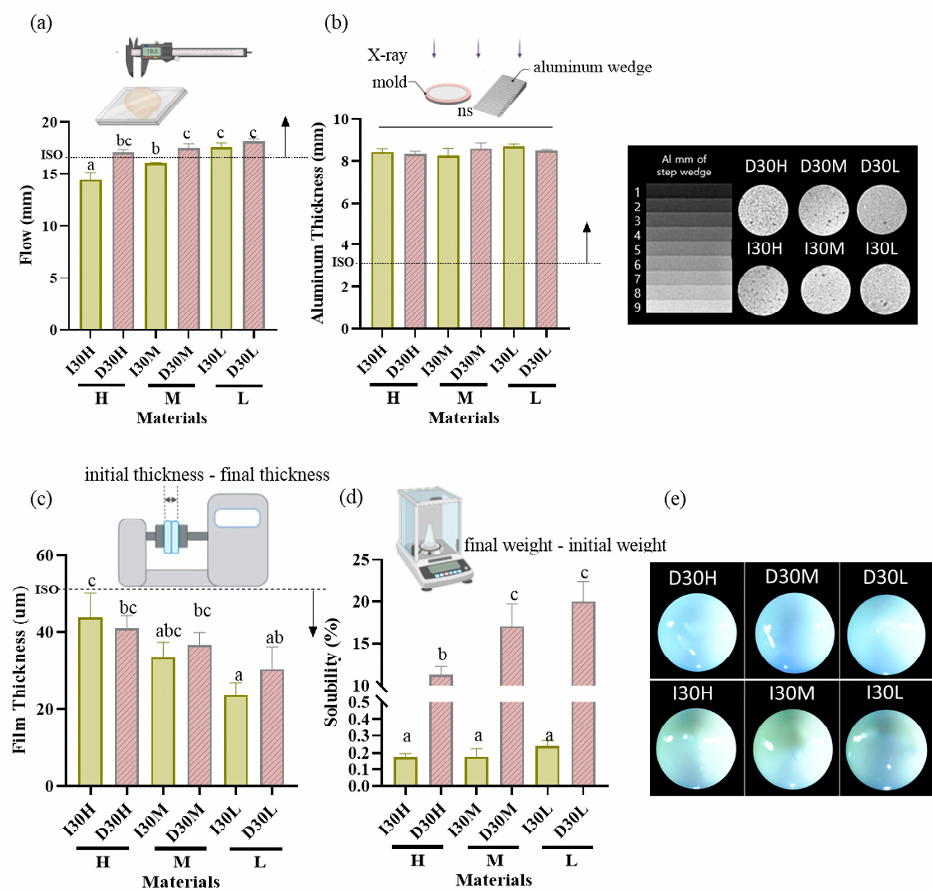
Figure 1. Physical properties of iodoform-based and NaI-based pastes (I30 and D30). ( a ) Flowability. All values except I30H and I30M were above 17 mm (ISO standard). ( b ) Radiopacity. All the aluminum thickness values were above the 3 mm Al (ISO standard). ( c ) Film Thickness. All groups met the ISO standard, which is under 50 µm. ( d ) Solubility. The solubility of D30 was higher than I30. ( e ) Optical microscopy images depicting the D30 and I30 groups, distinguished by their colors. The D30 group appears blue-green, whereas the I30 group appears yellow to white. Arrows indicate ISO 68762012 standards. Different superscript letters mean statistically significant differences among groups while ns mean not significant. Error bars mean standard deviations ( p < 0.05).